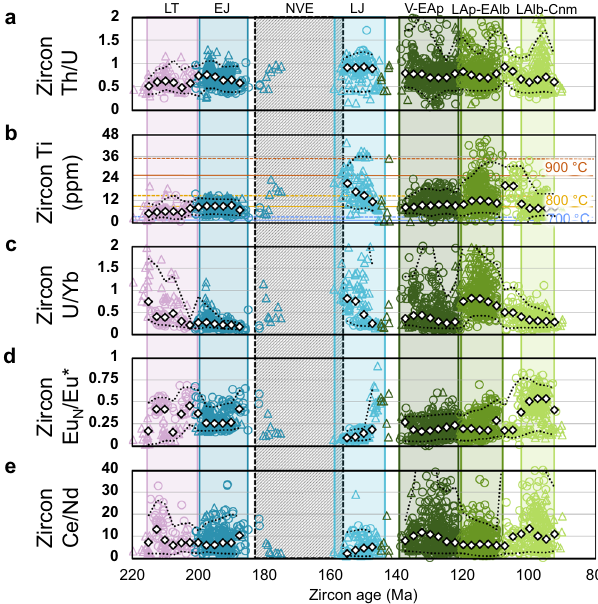
Fig. 3 Zircon petrogenetic indicators. The trace element data in ( a , c – e) and the zircon Ti content ( b ) are used to estimate the following parameters: a extensional and compressional periods in subduction environments 43 . b Crystallisation temperatures; 44 reference lines consider a [SiO 2 ] = 1 and a [TiO 2 ] = 0.5 (solid lines) and 0.7 (dashed lines) 45 . c Enrichment and/or crustal contamination of the magmatic source 13 . d Oxygen fugacity changes and plagioclase fractionation prior to zircon crystallisation. Eu* = [Sm N × Gd N ] 0.5 . e Oxygen fugacity during zircon crystallisation. All geochemical parameters are plotted according to their corresponding zircon 238 U/ 206 Pb age. Data source: triangles (this study: Supplementary Data 1); circles (ref. 22 Supplementary Data 2). Symbol colours refer to the age of the plutonic complexes as shown in Fig. 1. Rhomboidal white symbols and lower and upper dotted black lines represent median, 5th and 95th percentiles of each series (kernel density estimation with 2.5 Ma bandwidth and 5 Ma bin width, except for ( e ). LT, Late Triassic (215 – 203 Ma). EJ, Early Jurassic (200 – 185 Ma). LJ, Late Jurassic (160 – 145 Ma). V-EAp, Valanginian to early Aptian (138 – 121 Ma). LAp-EAlb, late Aptian to early Albian (120 – 108 Ma). LAlb-Cnm, late Albian to Cenomanian (103 – 94 Ma). Colour bands according to Fig. 1. NVE, La Negra volcanic event (~180 – 155 Ma), is represented by the dashed grey band. the